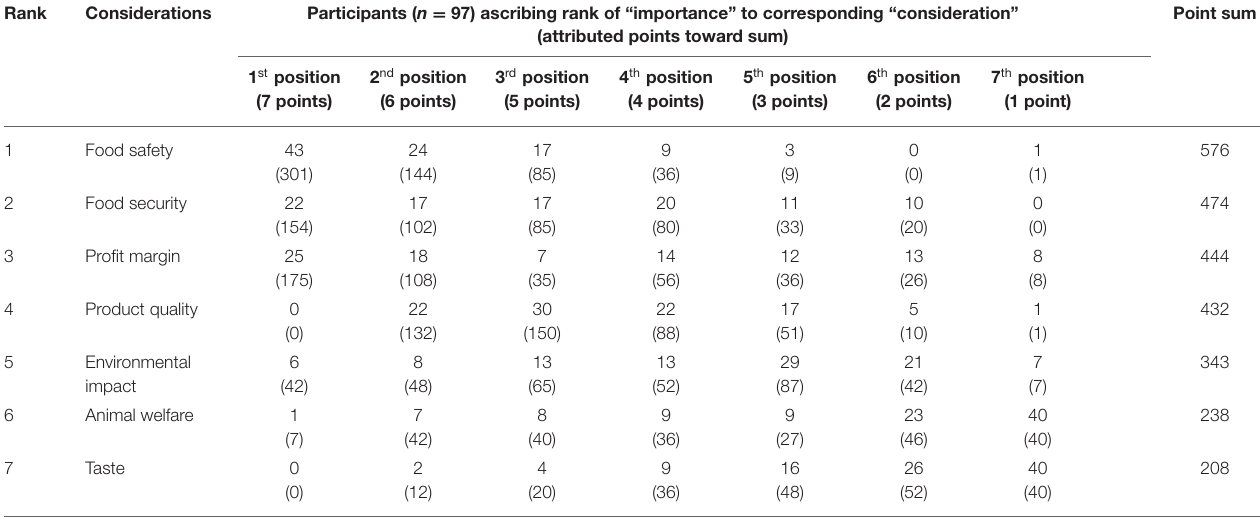
TABLE 3 | Participants’ ( n = 97) responses when asked to ascribe a rank of “importance” to agricultural considerations. Rank